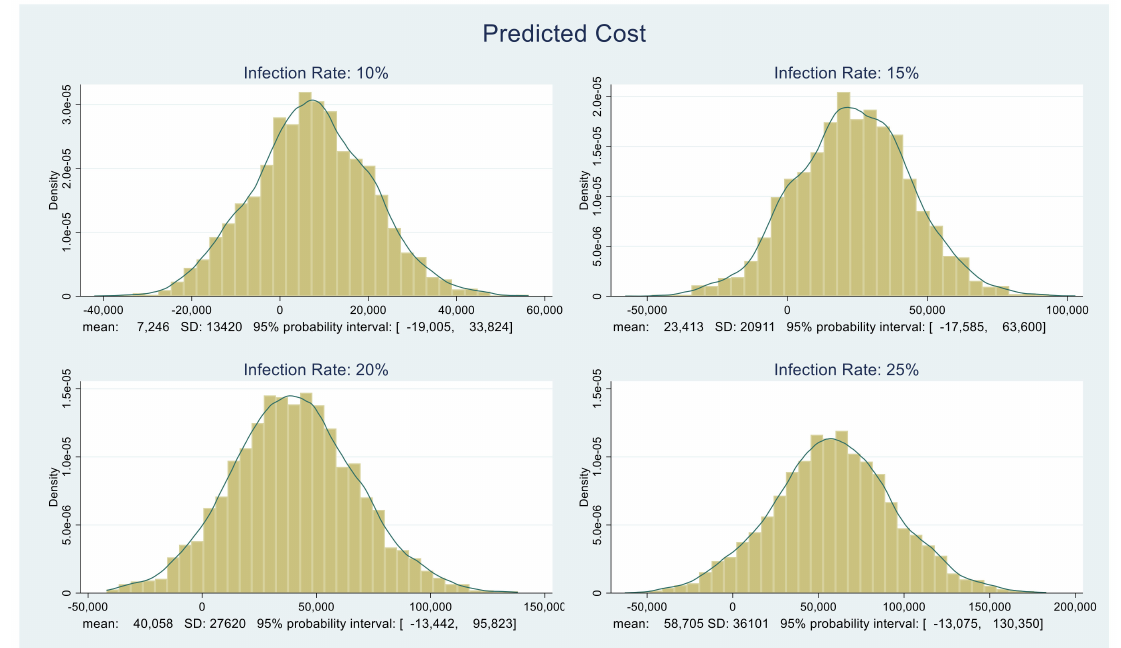
Figure 5. Predictive distributions of medical and fatality costs in dollars.